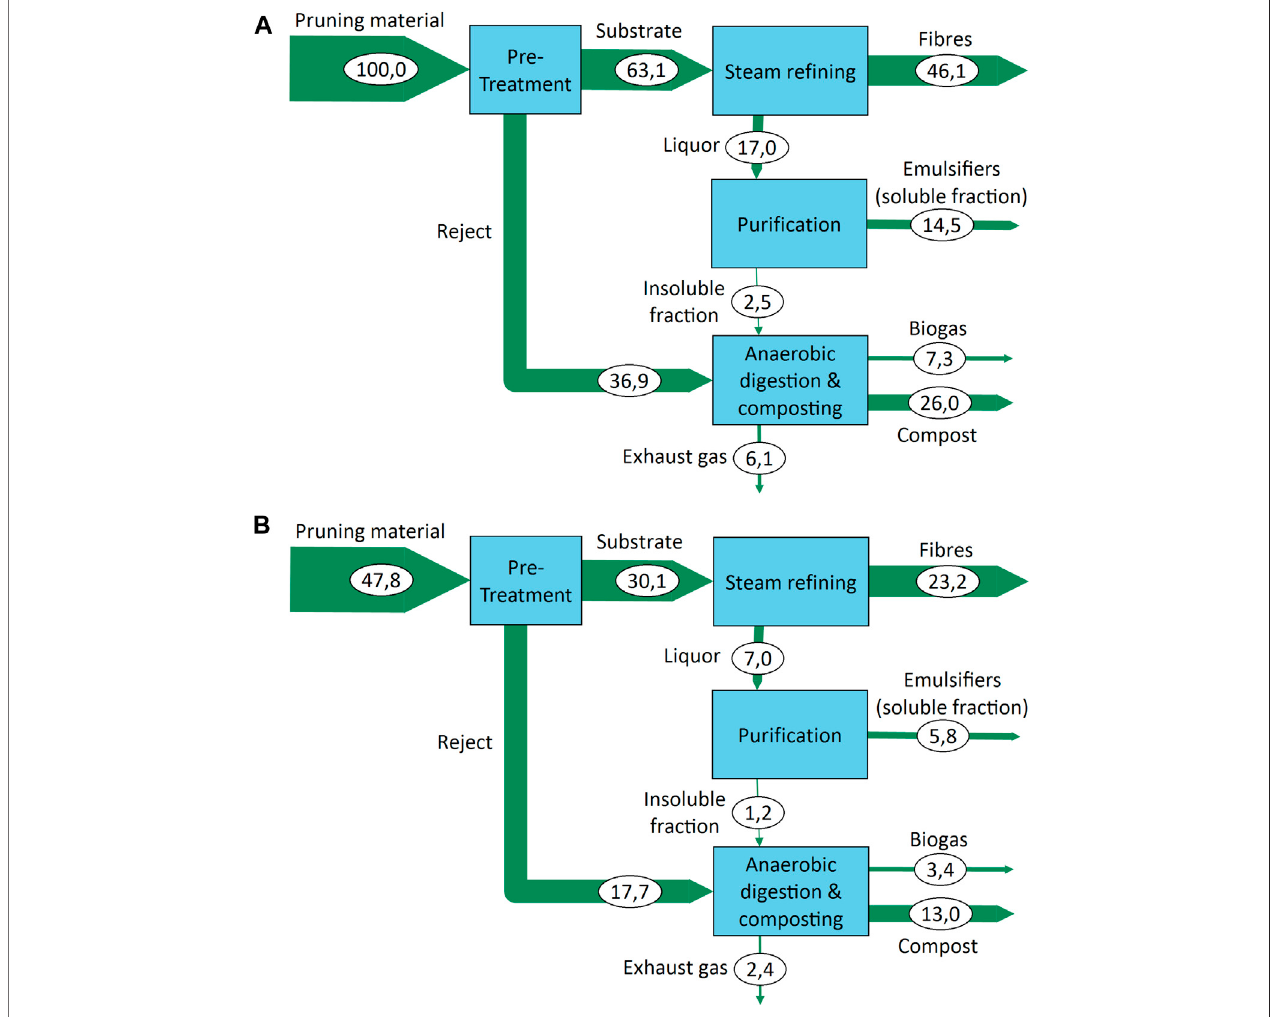
FIGURE 5 | Sankey diagram of the material fl ow analysis of the studied process network with traced dry matter (A) and carbon (B) .